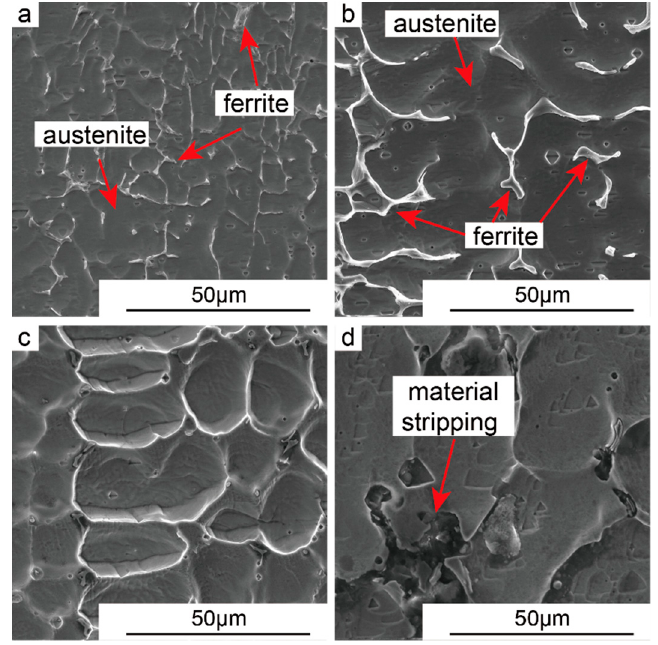
Figure 6. SEM microstructure of as-deposited wall: ( a ) Bottom, ( b ) middle, ( c ) upper, and ( d ) top